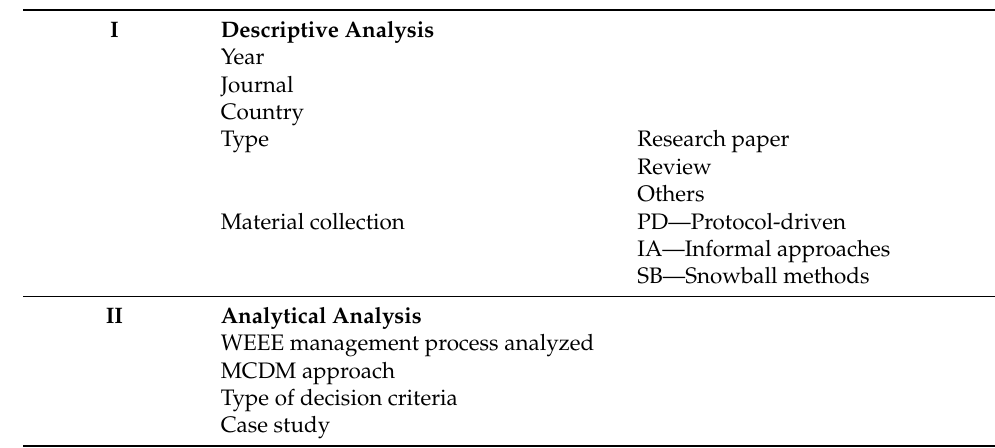
Table 3. Analysis